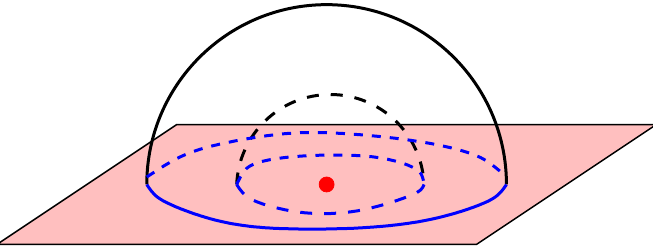
Figure 7 . Counting operators on the boundary of half-space R 2 (cid:2) R + leads to combined 2d-3d half-index on S 1 (cid:2) D 2 . In radial quantization, the boundary is foliated by concentric circles, which form T 2 boundary of S 1 (cid:2) D 2